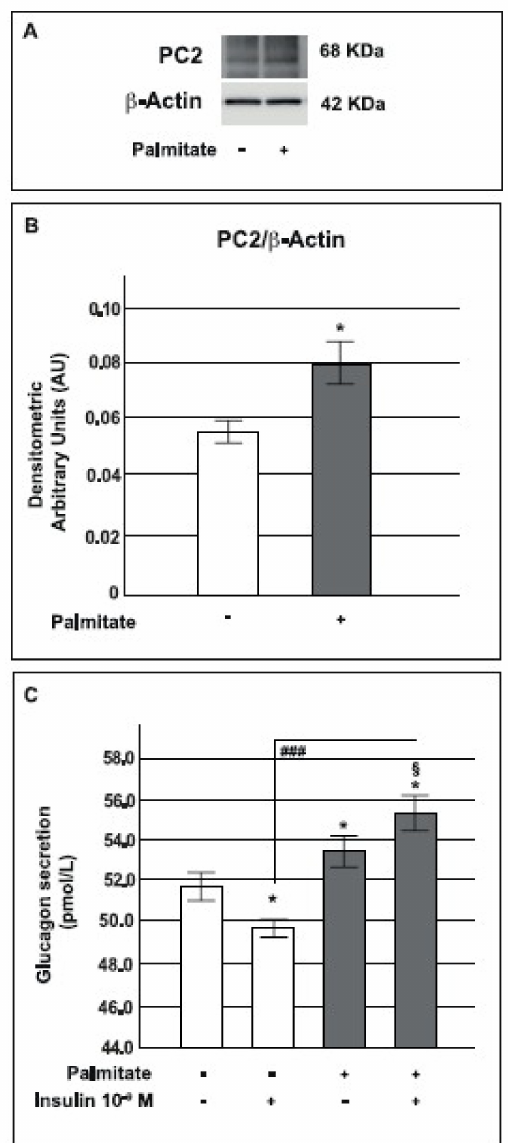
Figure 7. Effects of pre-exposure to palmitate on PC2 protein expression and glucagon secretion. A : representative Western blot for PC2 and β -actin from control and palmitate GLUTag treated cells (0.5 mM for 24 h). B : corresponding densitometric analysis in control cells (open bars) and in cells exposed to palmitate (gray bars). * p < 0.05 vs. control (1-way ANOVA followed by Bonferroni test, n = 3). C : glucagon secretion in control cells (open bars) and in cells pre-exposed to 0.5 mM of palmitate for 24 h (gray bars). * p < 0.05 vs. basal level in the control group; ### p < 0.001 vs. insulin stimulated control group; § p < 0.05 vs basal level in the palmitate group (1-way ANOVA followed by Bonferroni test, n = 4); (+) means presence, (-) means